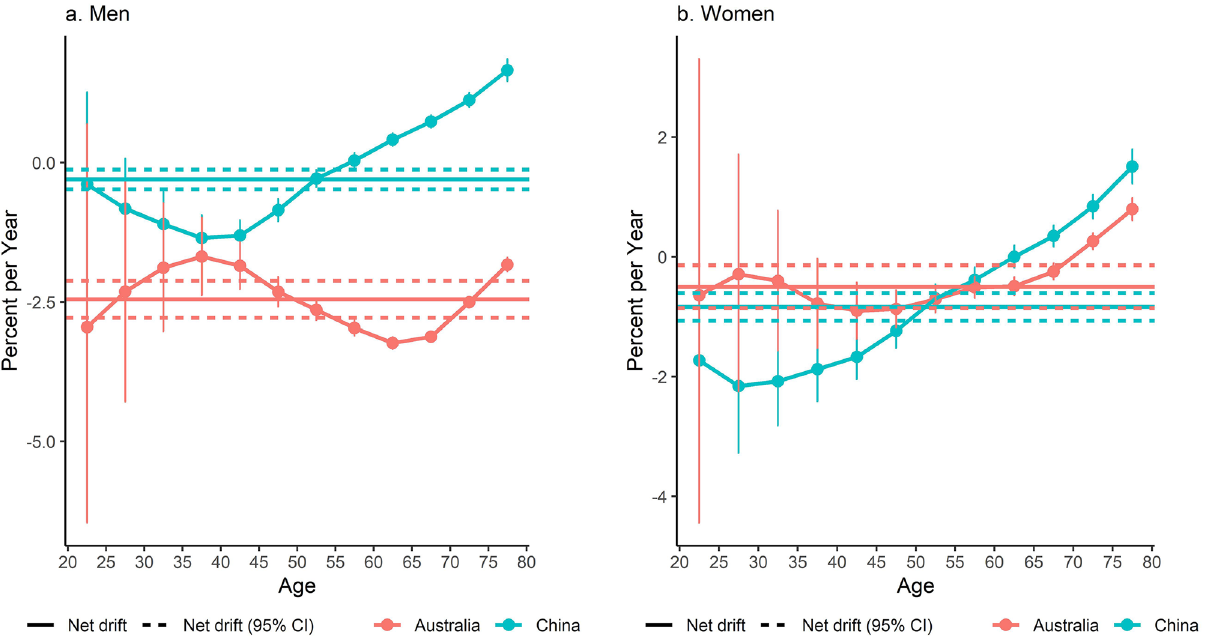
Figure 4. Net drift and local drift values for lung cancer mortality rate by sex in China and Australia, 1990 to 2019. Net drift represents the annual percentage change in age-adjusted lung cancer mortality rate over time, which indicates the overall log-linear trend by period and cohort. Local drifts represent the annual percentage changes of lung cancer mortality rate in each age group over time, which indicate the age-specific log-linear trends by period and cohort. ( a ) Shows that the net drift values were negative among both genders in the two countries, with Australian men having a significantly lower value than Chinese men. This indicates that the overall lung cancer mortality rate decreased more strikingly in Australian men than their Chinese counterparts. ( b ) Shows that the difference in the net drift value between Chinese women and Australian women was nonsignificant. The local drift values were positive in Chinese men and women aged between 65 and 79, suggesting lung cancer mortality rates were increasing in these age groups. In Australia, lung cancer mortality rates were decreasing with the exception of women aged between 75 and 79 (local drift values were positive in women of these age